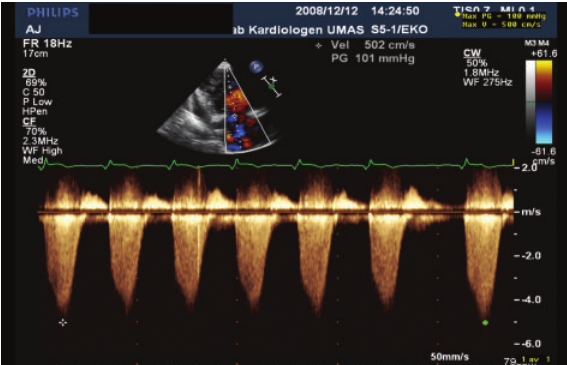
Figure 3: Estimation of the pulmonary arterial systolic pressure (PASP) from the tricuspid regurgitant jet (V TR ). The latter is measured using continuous wave Doppler. PASP is calculated from simplified Bernoulli equation, PASP = 4 × V TR2